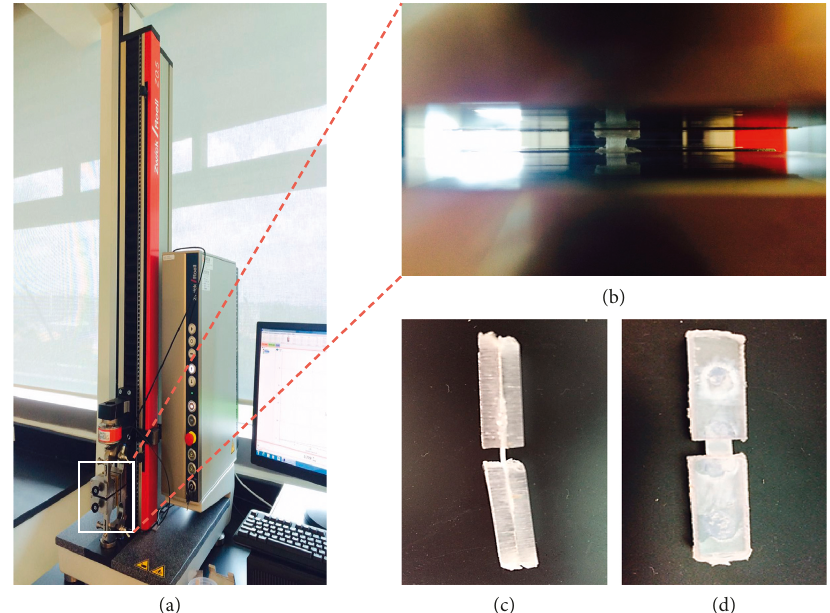
Figure 3: Tensile test setup and sample preparation. (a) Zwick Roell static testing machine for tensile test. (b) Partial magnification of sample placing. (c) Side view of tensile test sample, four pieces of acrylic slabs with super glue were used to attach the samples. (d) Top view of tensile test sample.